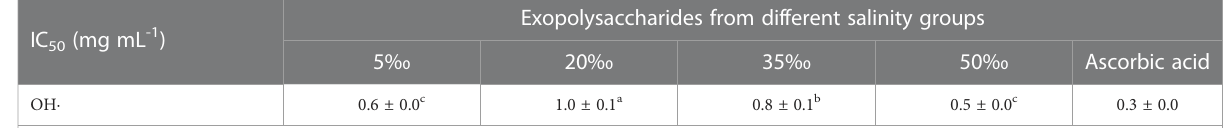
IC 50 : half maximal inhibitory concentration. Different letters denoted signi fi cant differences among the values of IC 50 of different hydroxyl radical scavenging activity of exopolysaccharides in different